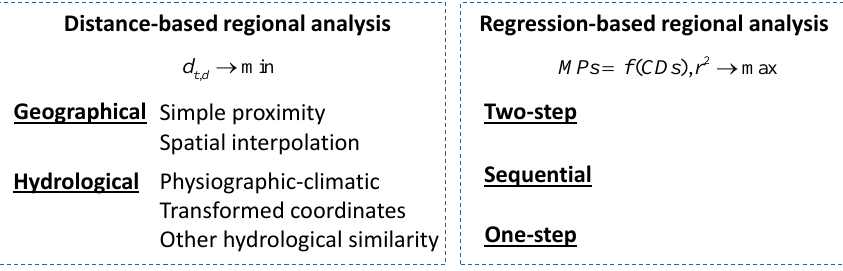
based on their hydrological similarity and these methods are reviewed in Sect. 2.2 Hydrological